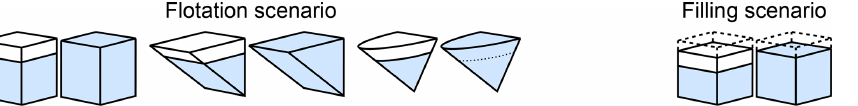
Figure 5. Schematic of the various scenarios that we considered in our simulations, illustrating basin geometry, presence/absence of remnant ice, and whether drainage initiated when the lake reached flotation depth or while the basin was filling. For the flotation scenario, we prescribe Q in = 0m 3 s − 1 , S 0 = 1m 2 , and h w , 0 = (H b − h i )ρ i /ρ w (flotation depth). For the filling scenario simulations, we prescribe the discharge into the basin as Q in = 20m 3 s − 1 , the initial conduit cross-sectional area as S 0 = 0 . 1m 2 , and the initial water level h w , 0 = 10m. The basins all have the same initial volume (year 0 in the ice flow model), but as the ice dam thins the changes in basin volume are nonlinear for the cone- and wedge-shaped basins. The simulations with remnant ice assume the basin is completely filled with ice at year